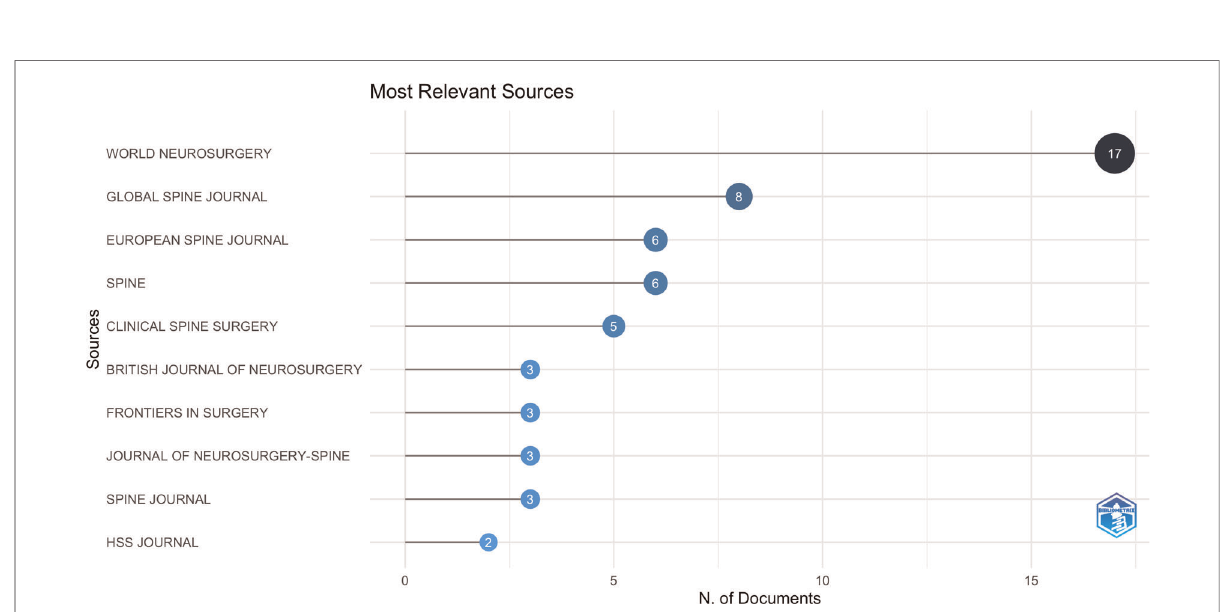
FIGURE 3 Top 10 journals with the highest number of publications in the fi eld of spine surgery and COVID-19 (generated by